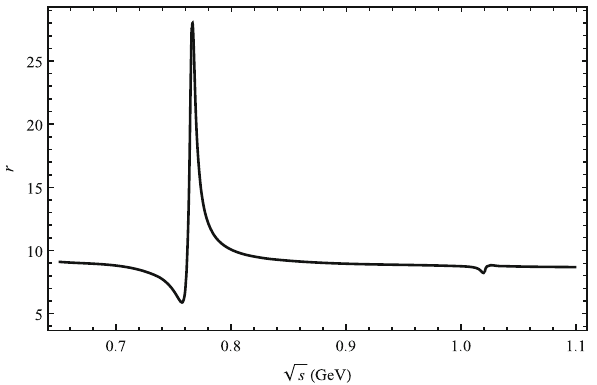
√ s corresponding to central param-